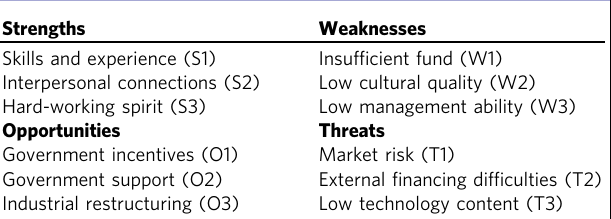
Table 3 SWOT matrix of migrant workers returning home to start